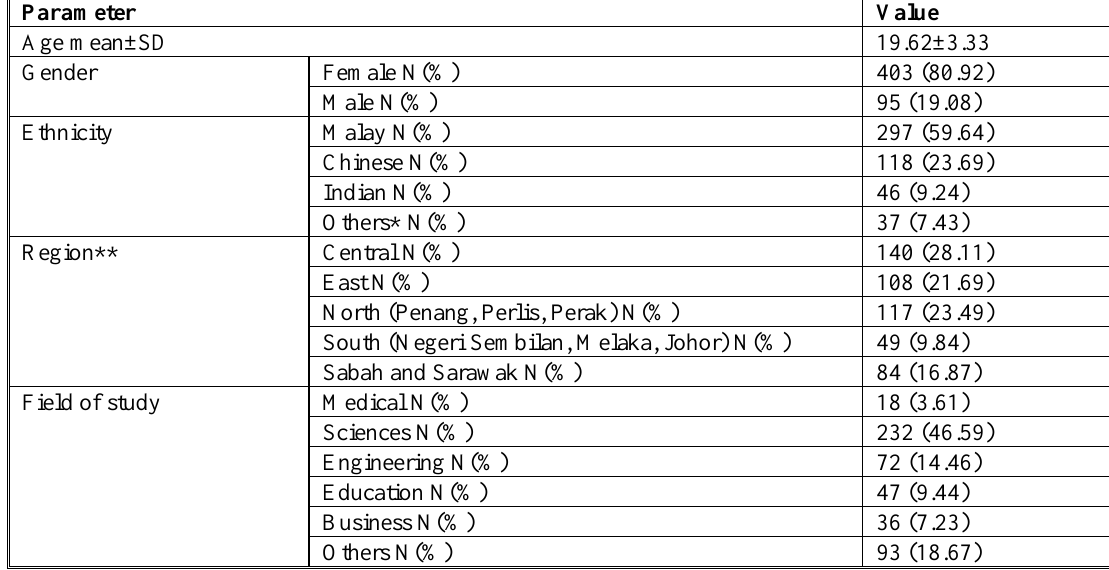
Table 1. Demographic data of